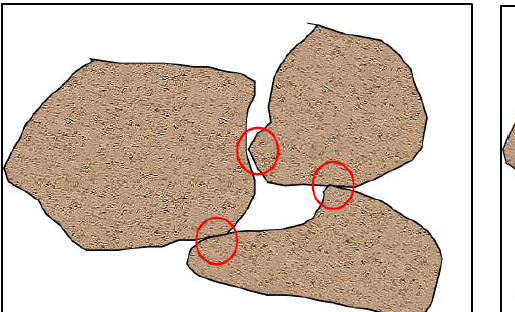
Figure 15. Transformation of the contact pattern of soil particles of ( a ) point–surface contact, ( b ) surface–surface contact.